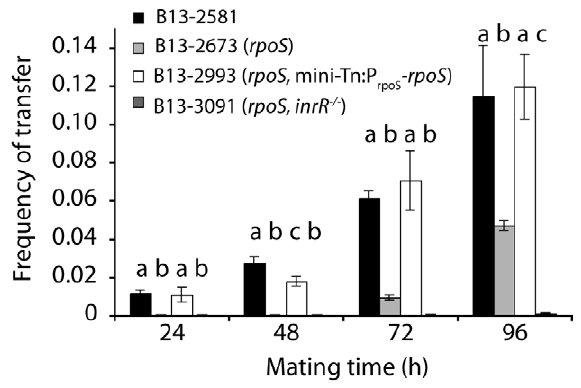
Figure 3. Effect of rpoS interruption on ICE clc transfer from P. knackmussii B13 to P.putida UWC1 as recipient as a function of mating time. Frequency of transfer expressed as number of transconjugant per number of donor colony forming units. Note that very low frequencies appearing on this scale as close to ‘zero’ are still detectable (exact values are given in Table S1). Letters above bar diagrams indicate significance of difference (P , 0.05) in a Tukey’s post- hoc test on sample variances per mating time group (one-way